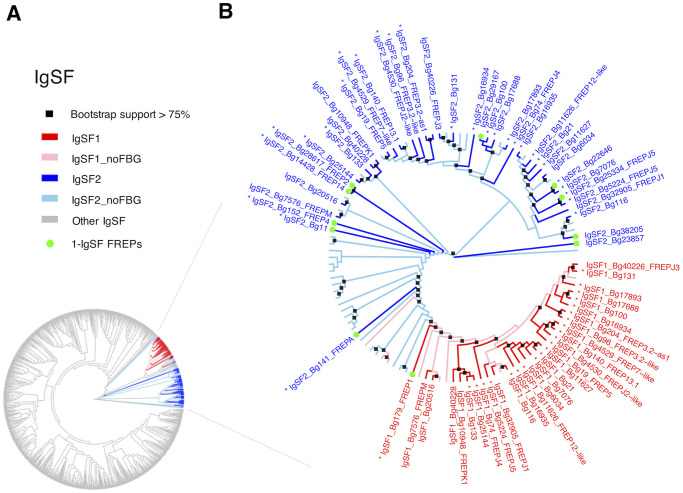
Unrooted Maximum Likelihood (ML) trees of IgSF domains identified in B. glabrata with new HMM profile search.A: ML tree with all IgSF domains from search using the 38 new IgSF HMM profiles (in Fig 2). Gray branches in panel A represent other IgSFs predicted with 36 new HMM profiles, which are not associated with FBG domain; B: An ML tree for only IgSF1 and IgSF2 domains from B. glabrata. ML trees with 1000 bootstrap tests were constructed using IQ-TREE. Nodes with bootstrap support of 75 or higher were highlighted with black squares at the nodes in panel B. Any domains associated with FBG domain are colored in red (IgSF1) or in blue (IgSF2) and followed with name of best hit to published FREPs. IgSF1 or IgSF2 domains without association with FBG domain are colored in pink (IgSF1) or in light blue (IgSF2). Gene has been identified previously in the genome paper [32] is labelled with an asterisk next to the corresponding gene ID. 1-IgSF FREPs are labeled with a green dot at the end of the branches. All FREPs identified in this study were named with IgSF domain, the Vectorbase ID and the best hit to published FREPs.